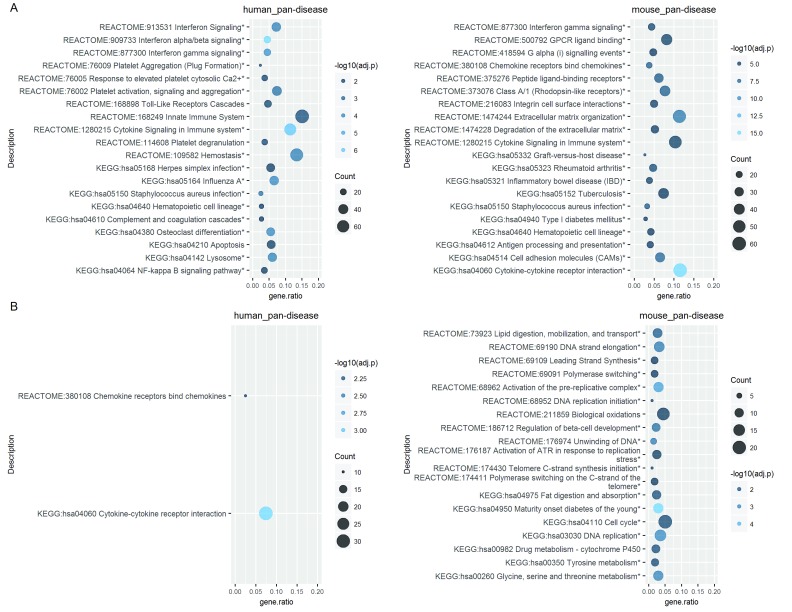
Pan-disease enrichment signatures.Over-representation analyses of the (
A) UP genes and (
B) DOWN genes (PFP <= 0.05) identified by using all CGPs from each species in the meta-analysis. The analyses were performed in both R and ToppGene; the top 20 enriched terms identified in R are shown. Terms found also in ToppGene are indicated by an asterisk (*). P-values are adjusted by Benjamini and Hochberg (BH) FDR correction (shown as 'adj.p'). Counts (indicated by circle size) and gene ratios (x-axis) respectively denote the number and proportion of genes in the UP or DOWN signature that also appear in the target gene set.